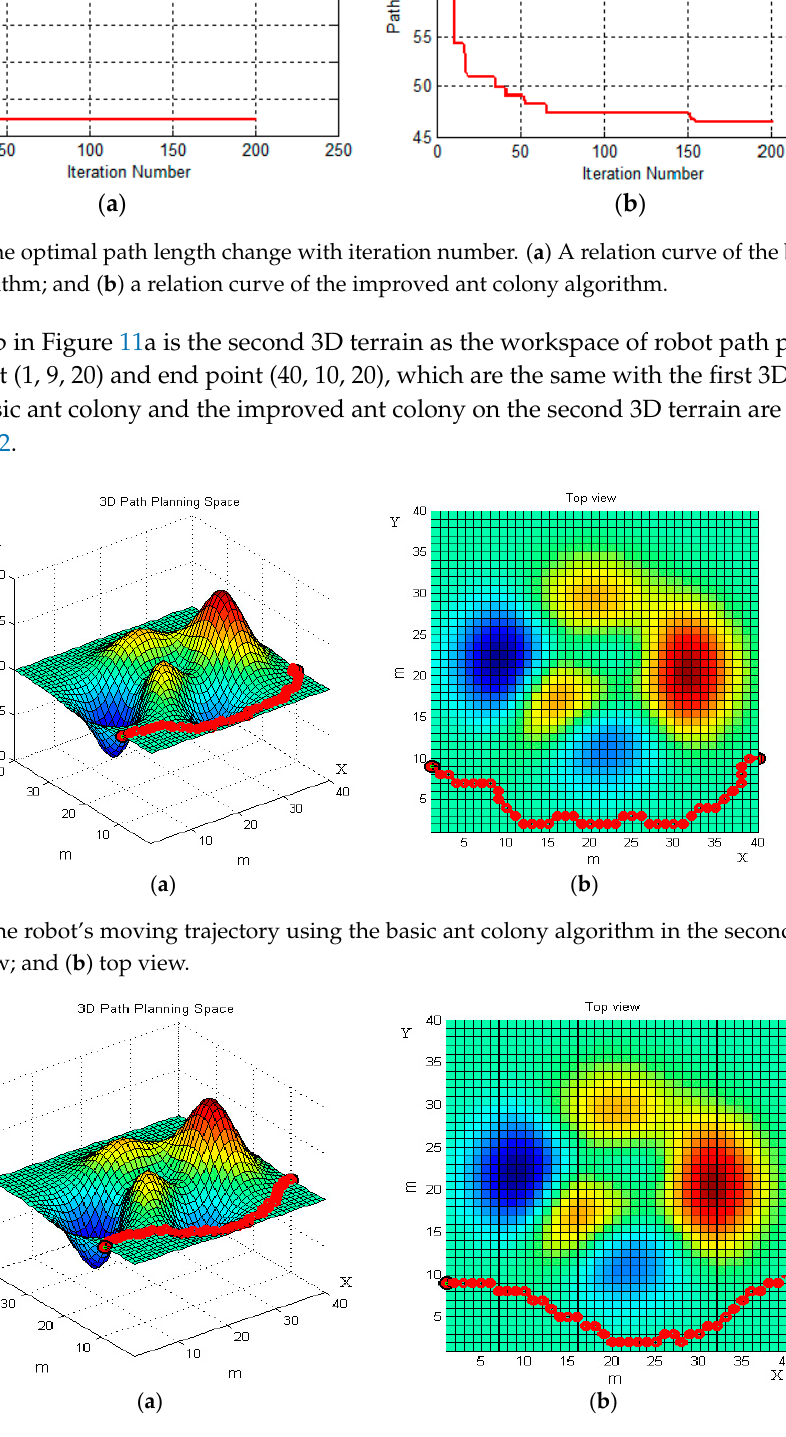
Figure 12. The robot’s moving trajectory using the improved ant colony algorithm in the second terrain. ( a ) Front view; and ( b ) top view.